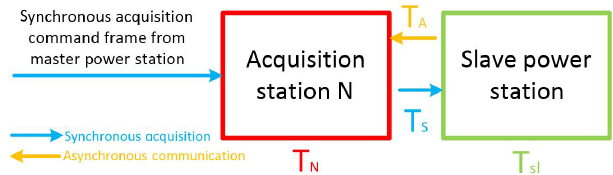
Figure 8. Schematic diagram of the delay time at the N th acquisi- tion station.